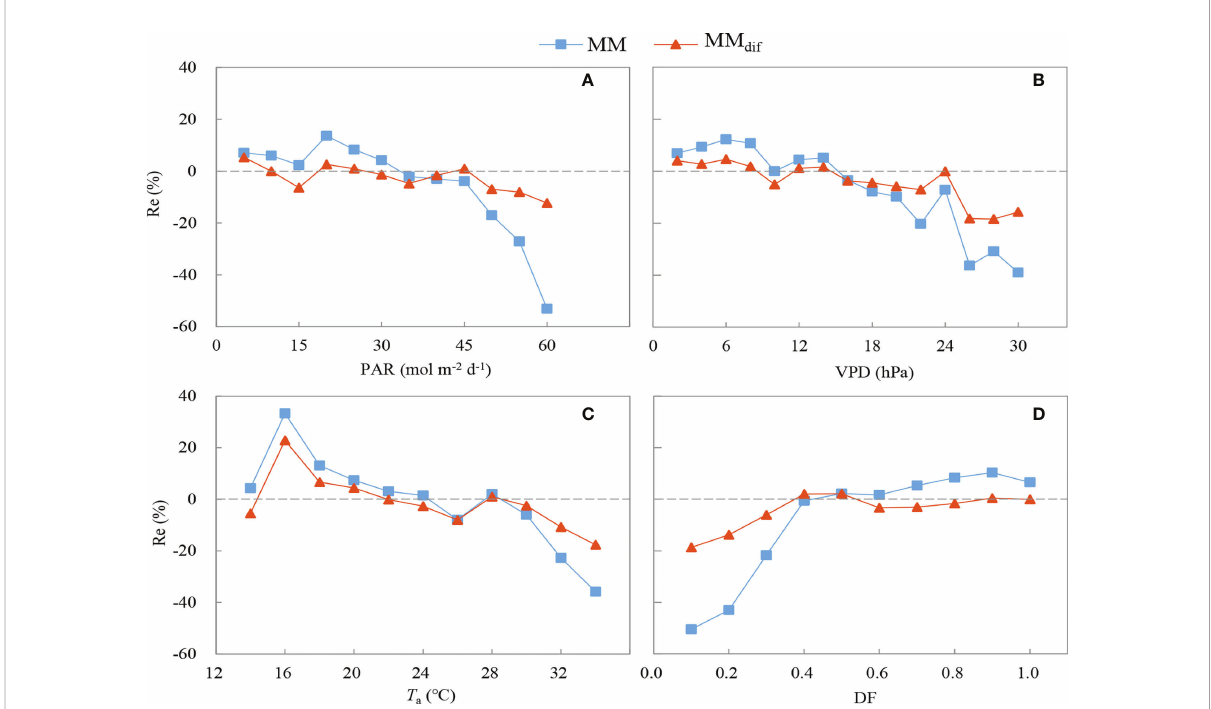
FIGURE 10 Relative error of the MM and MM dif models under different environmental conditions: (A) photosynthetically active radiation (PAR), (B) vapor pressure de fi cit (VPD), (C) air temperature ( T a ) and (D) diffuse fraction